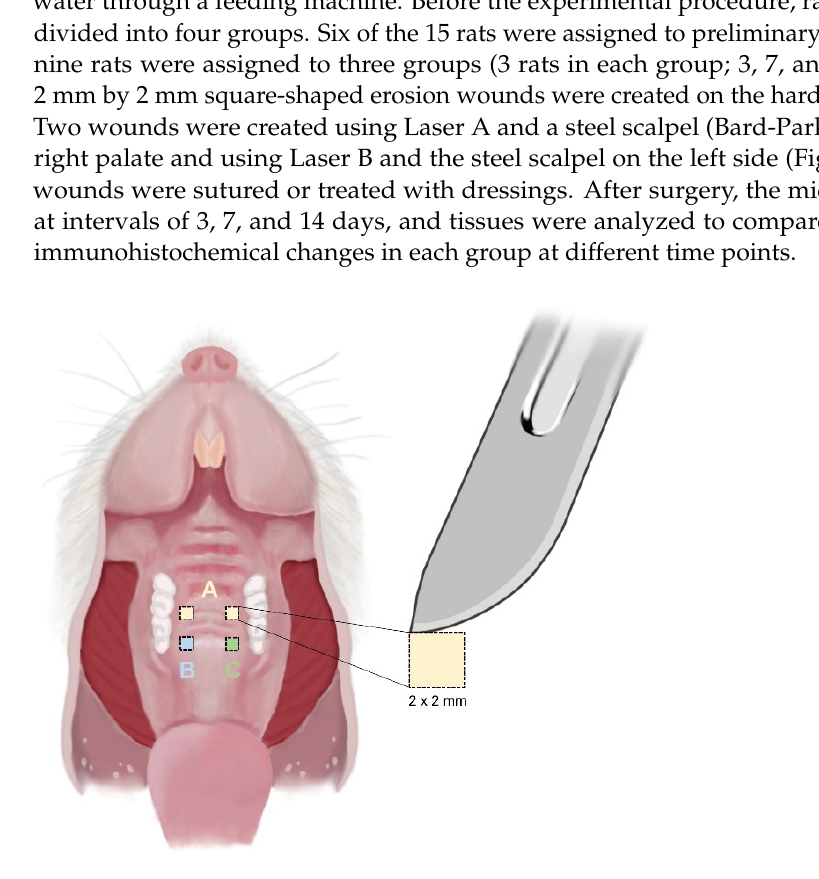
Figure 2. Schematic illustration showing erosion wound in the oral cavity in the rat. (A) Steel scal- pel. (B) Laser A. (C) Laser B. (B) Laser A. (C) Laser